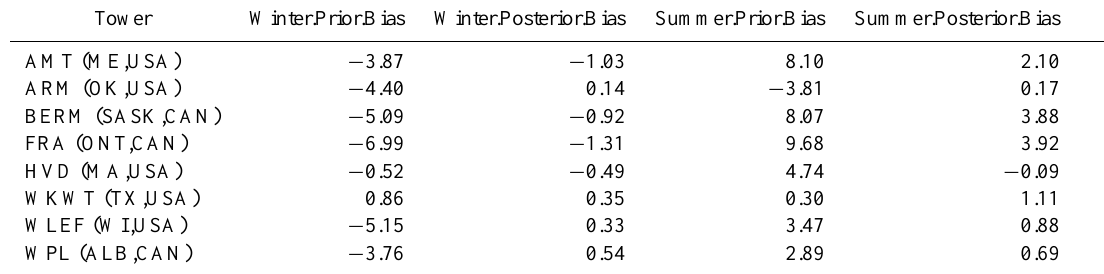
Table 1. Biases in Tower CO 2 partitioned by season.